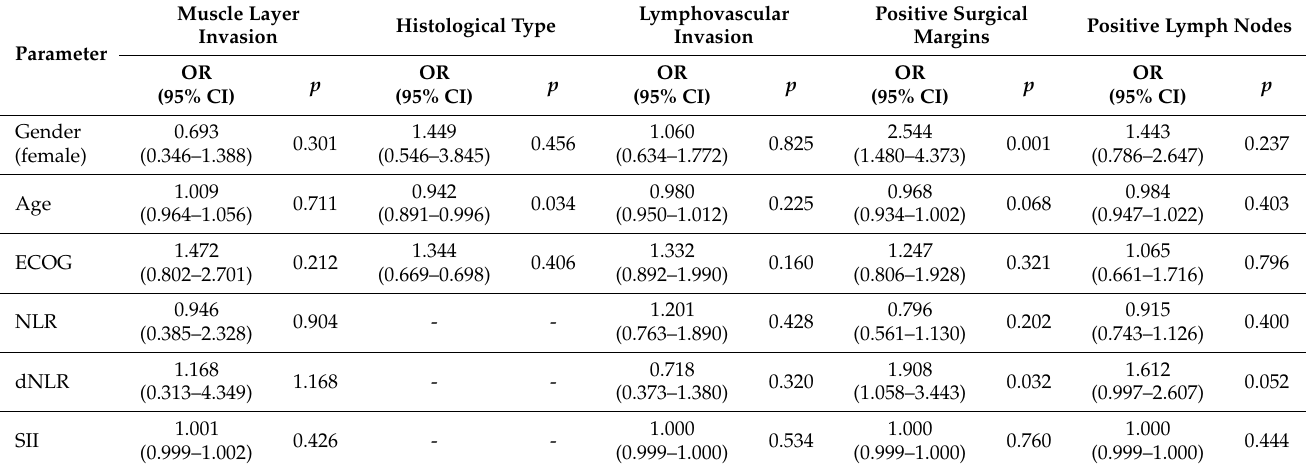
Table 9. Binary logistic regression analysis of independent predictors of bladder cancer histopatho- logical